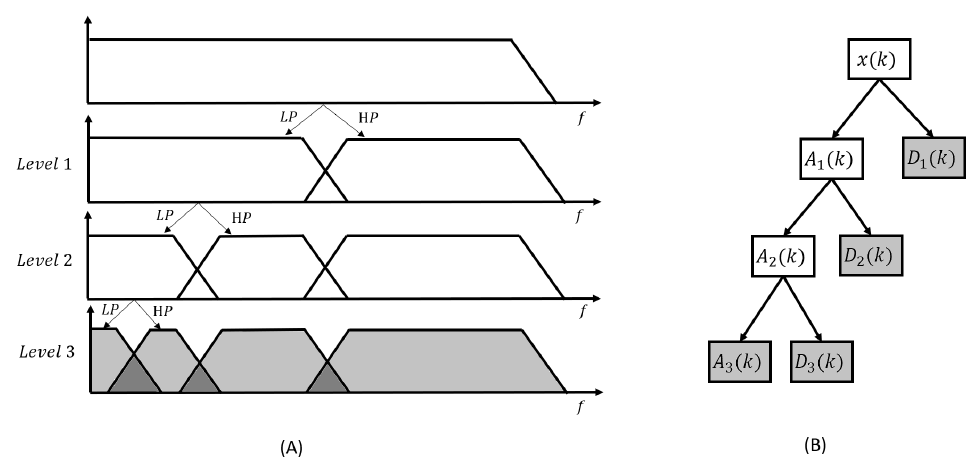
Figure 9. ( A ) Filter bank resulting from a a DWT at level 3 of decomposition and ( B ) the resulting coefficients of the DWT. The coefficients/components used in the DWT are presented in